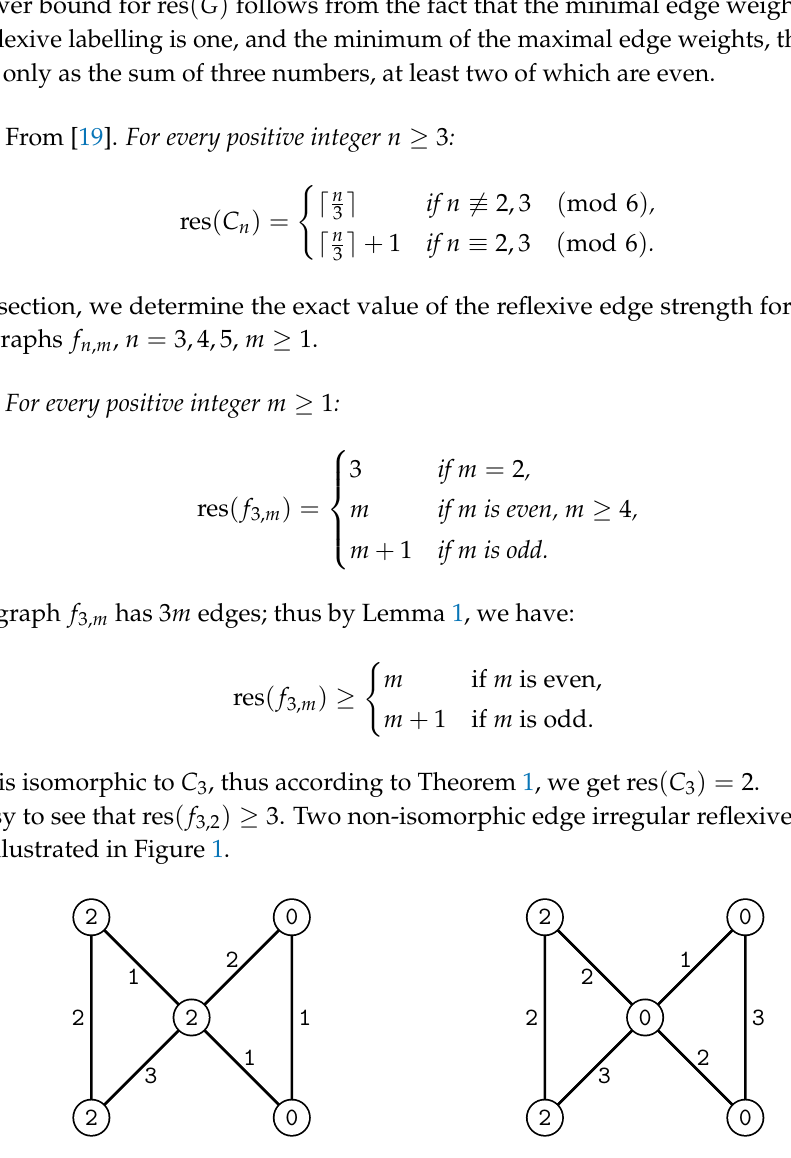
Figure 1. Two non-isomorphic edge irregular reflexive three-labellings of f 3,2